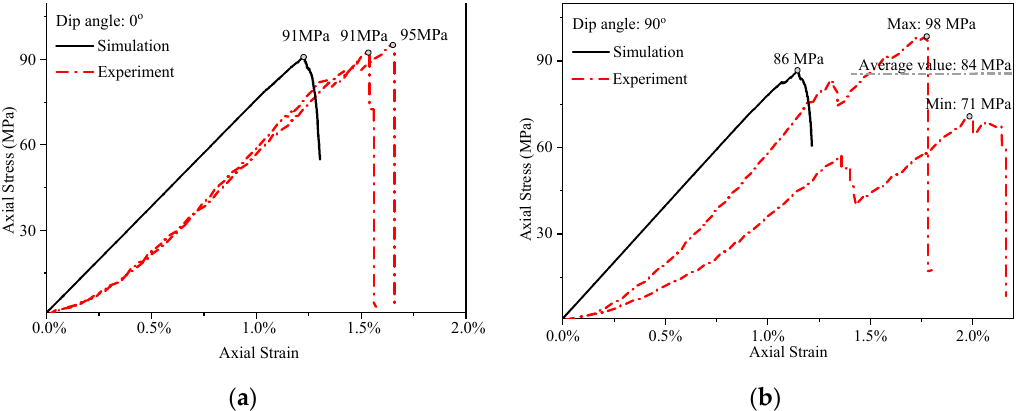
Figure 5. Comparison of stress-strain curves obtained by experiments and simulations: ( a ) at 0° and ( b ) at 90°.